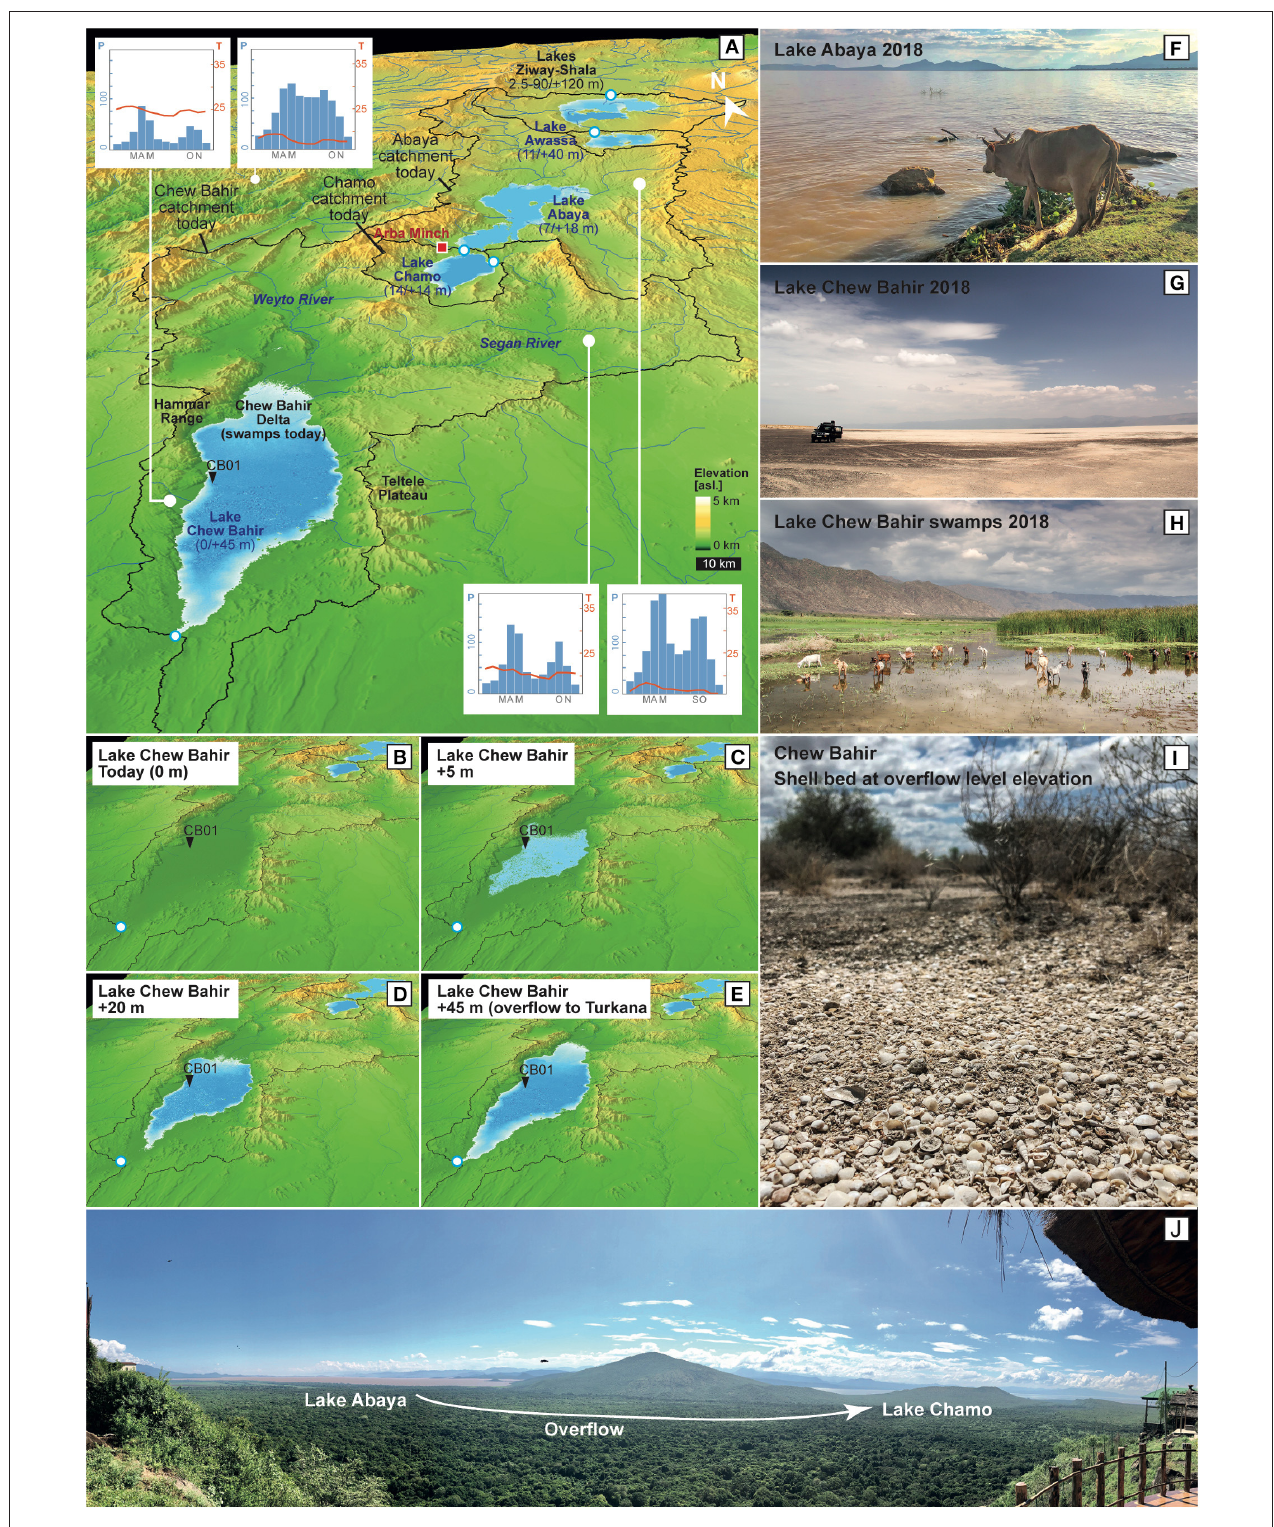
FIGURE 2 | Geographical features of the studied lake basins: (A) Modern catchment boundaries, monthly temperature means in ◦ C and precipitation in mm/month (IRI, last accessed 11/2019), overflow sill locations (white-blue circles), and paleo-lake dimensions with modern/paleo-depths in numbers. (B–E) Modeling outputs of paleo-lake Chew Bahir‘s dimension during different lake filling steps from modern to + 5, + 20, and + 45m when reaching the overflow level. (F–J) Pictures from study sites by A. Junginger.